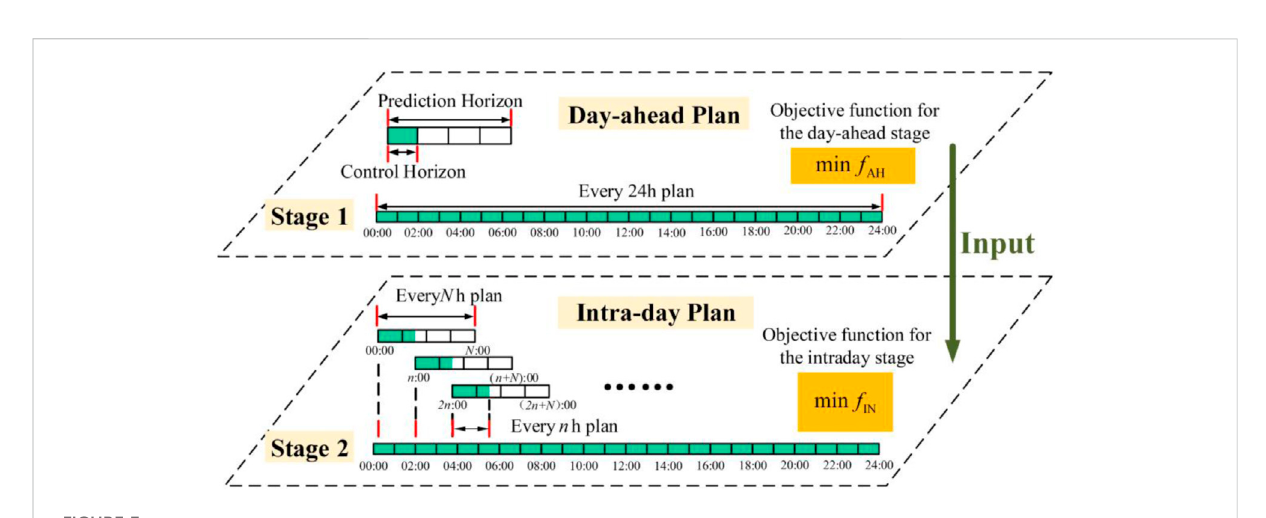
FIGURE 3 Two-stage optimisation